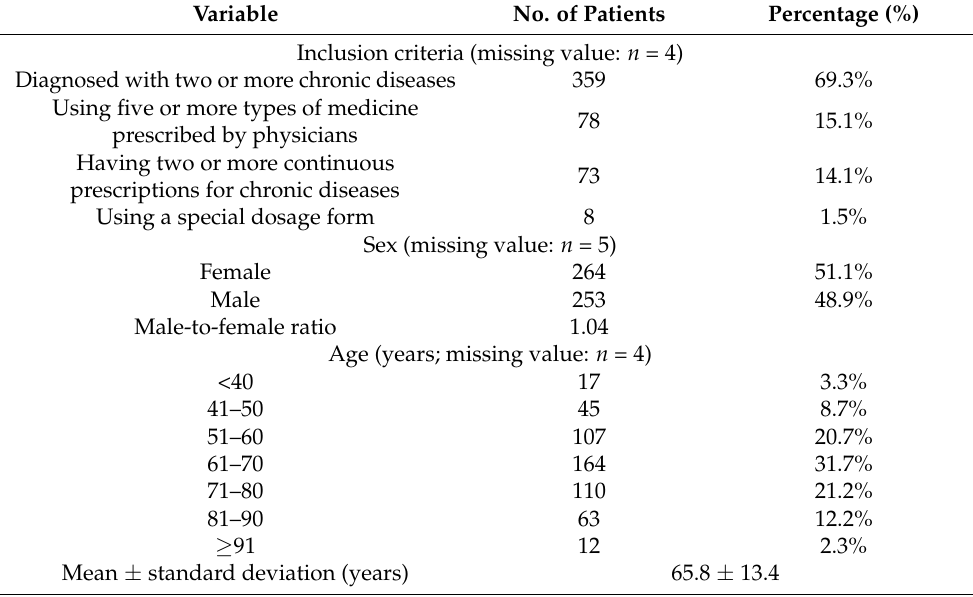
Table 3. Inclusion criteria of the patients receiving medication adherence consultations ( N =